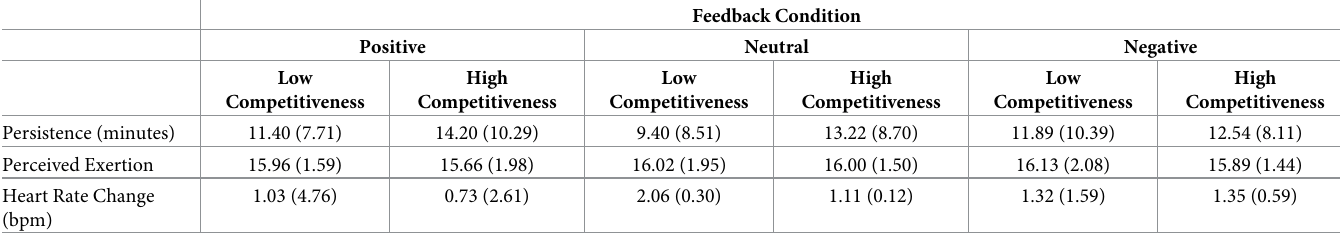
Table 2. Means (standard deviations) for performance measures for low and high trait competitiveness participants in each feedback